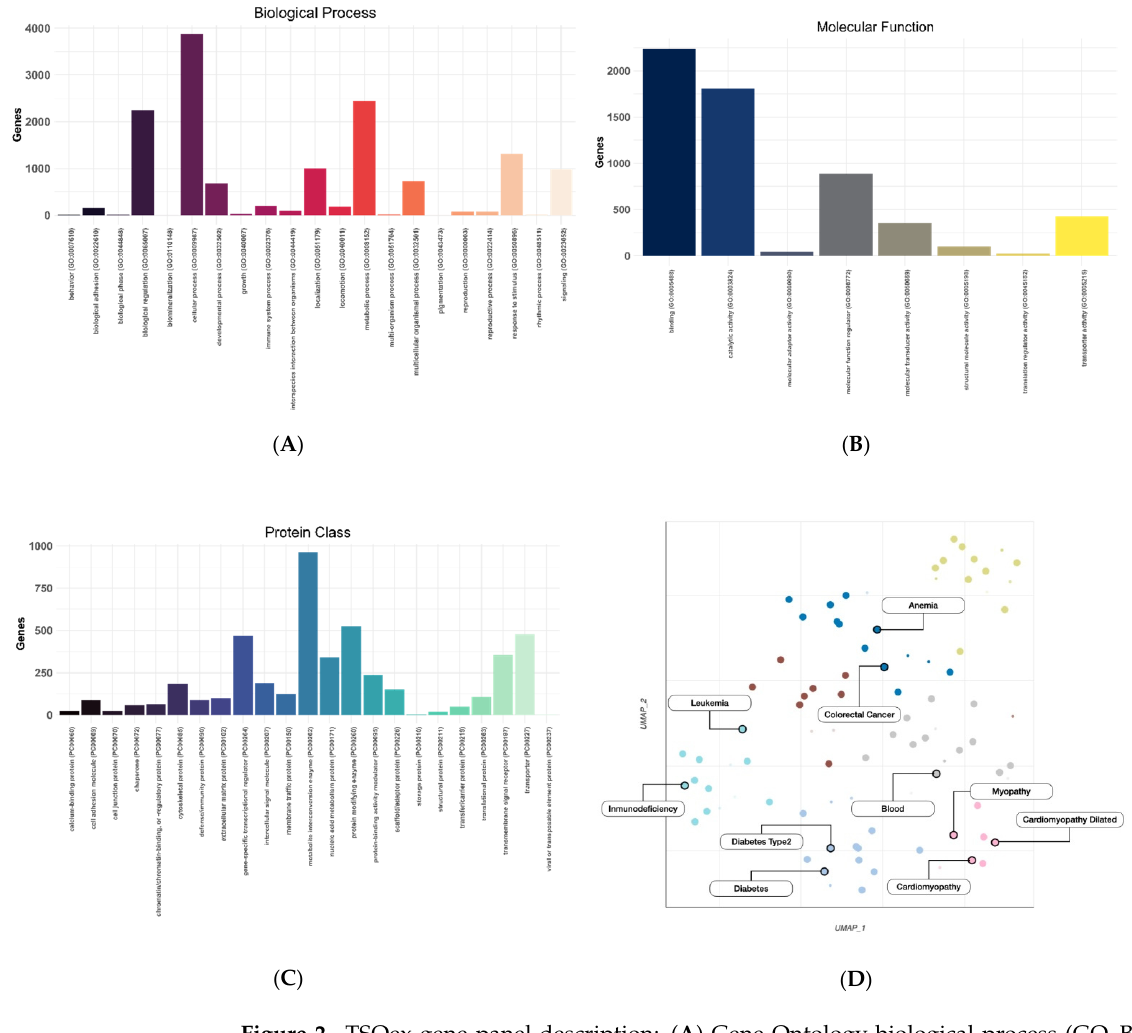
Figure 2. TSOex gene panel description: ( A ) Gene Ontology biological process (GO_BP) terms; ( B ) molecular function (GO_MF) terms; ( C ) protein class terms; ( D ) OMIM disease UMAP clustering. A, B, and C were determined using PANTHER GO-Slim gene lists. Fisher’s exact test was